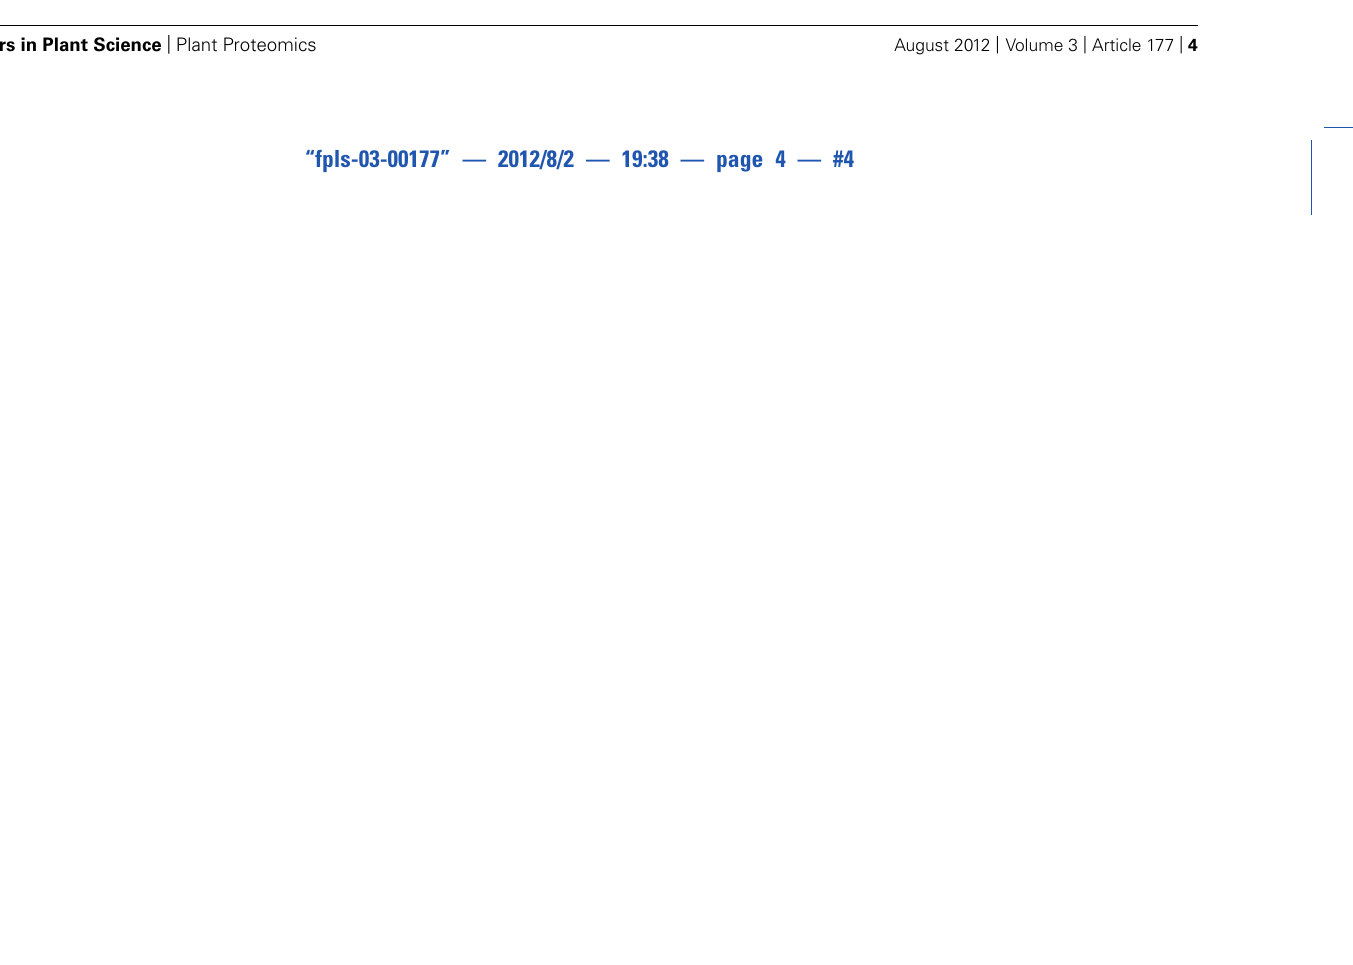
FIGURE 2 | Models for pattern recognition receptor-mediated phosphorylation pathways in Arabidopsis and rice. Left : Arabidopsis FLS2 and BAK1 associate with the membrane-associated cytoplasmic kinase Botrytis -induced kinase 1 (BIK1) in vitro and in vivo (Lu etal., 2010). In the resting state, Arabidopsis FLS2 interacts with BIK1. Flg22 perception induces FLS2 and BAK1 association and phosphorylation. Activated BAK1 phosphorylates BIK1, which in turn transphosphorylates the FLS2/BAK1 complex. Phosphorylated BIK1 is released from the FLS2/BAK1 complex to activate downstream intracellular signaling. No direct phosphorylation targets of FLS2 have yet been identified. At least two MAPK cascades are initiated downstream of activated FLS2, leading to the phosphorylation of the adaptor protein MKS1 and the transcription factors, AtWRKY33 and ERF104. Kinase-associated protein phosphatase (KAPP), a PP2C, blocks the activated FLS2 signaling and attenuates the downstream immune response. EFR-mediated immunity is believed to trigger the same MAPK cascades as FLS2. Right : In the resting state, rice XA21 forms an in vivo complex with the